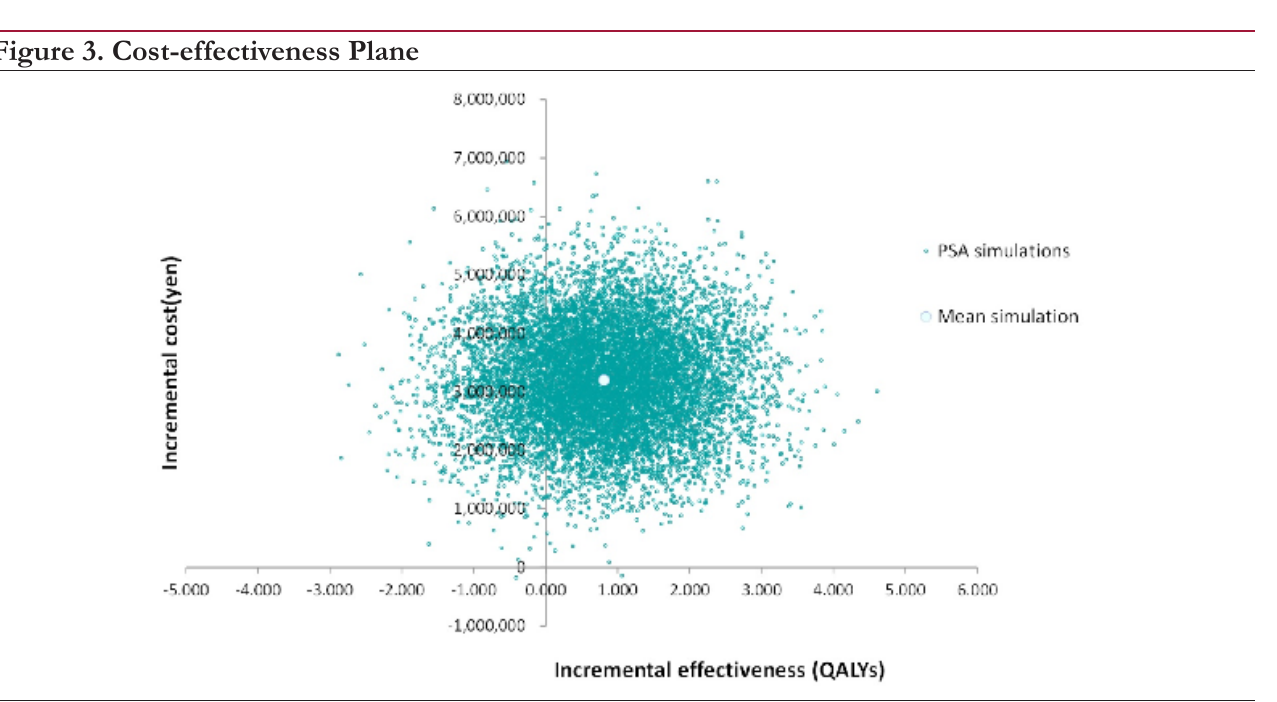
Figure 3. Cost-effectiveness Plane